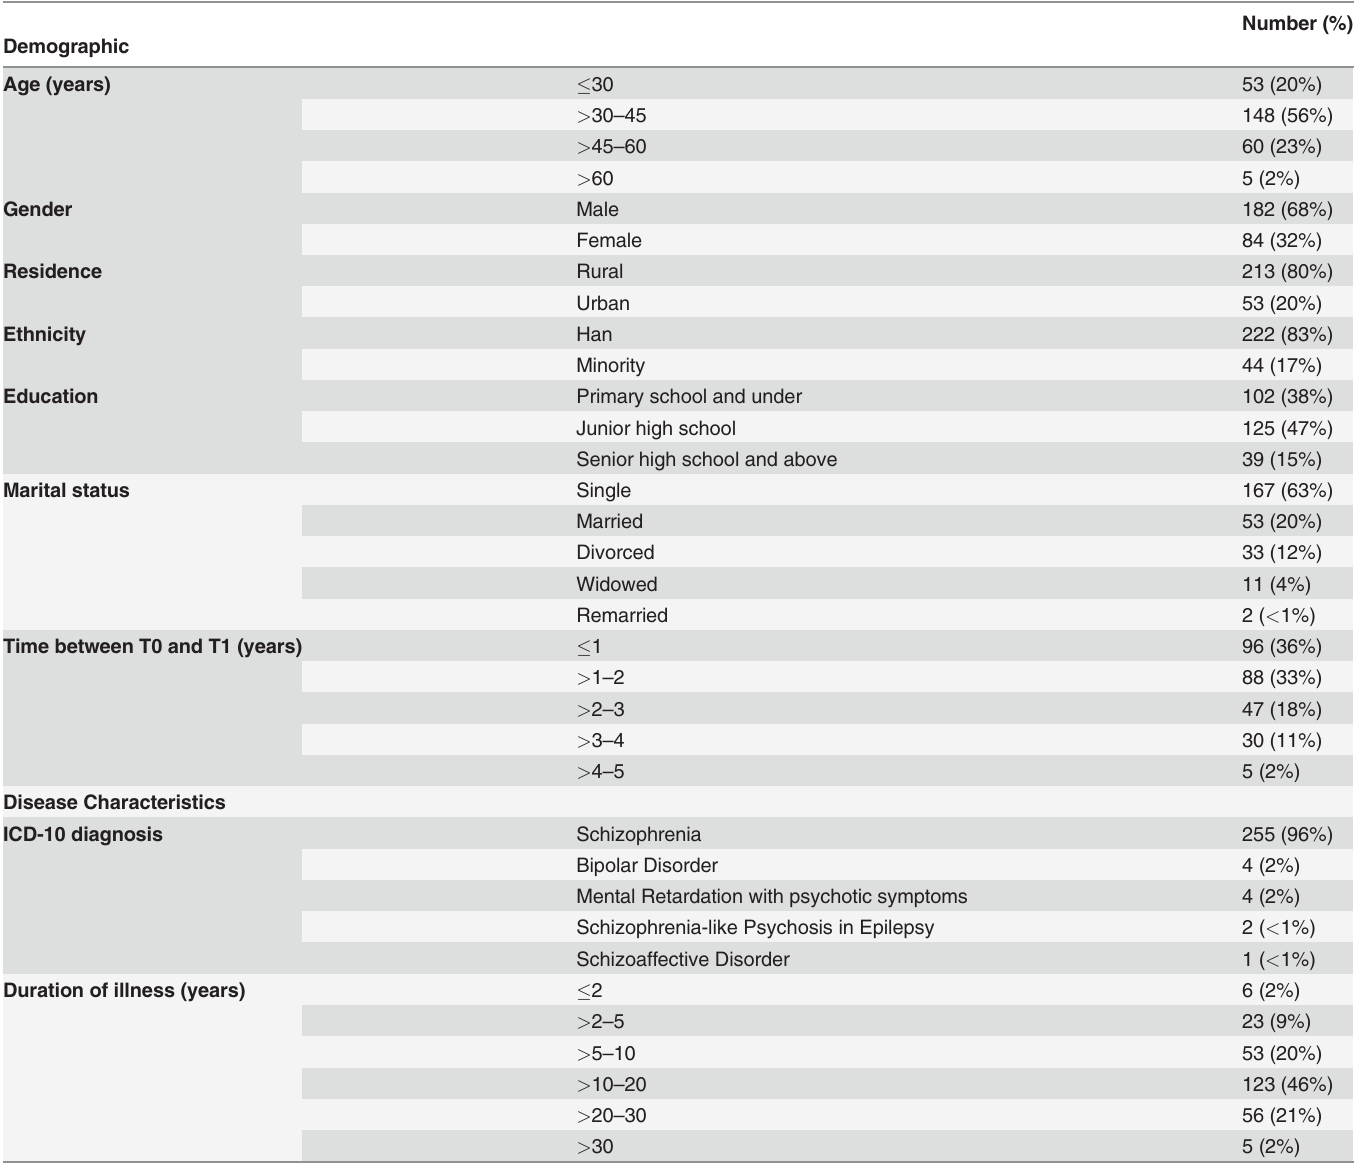
Table 1. Demographic and disease characteristics of 266 patients at the time of inclusion for Stage One study